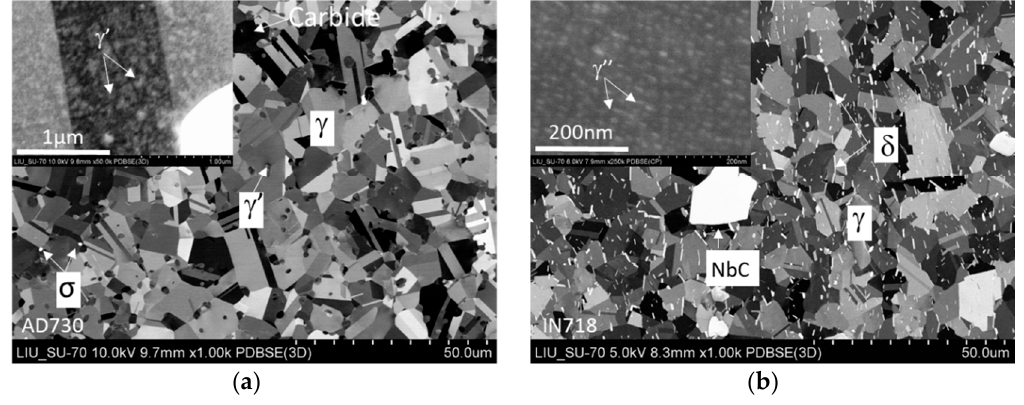
Figure 1. Microstructures of ( a ) AD730 ® and ( b ) IN718.